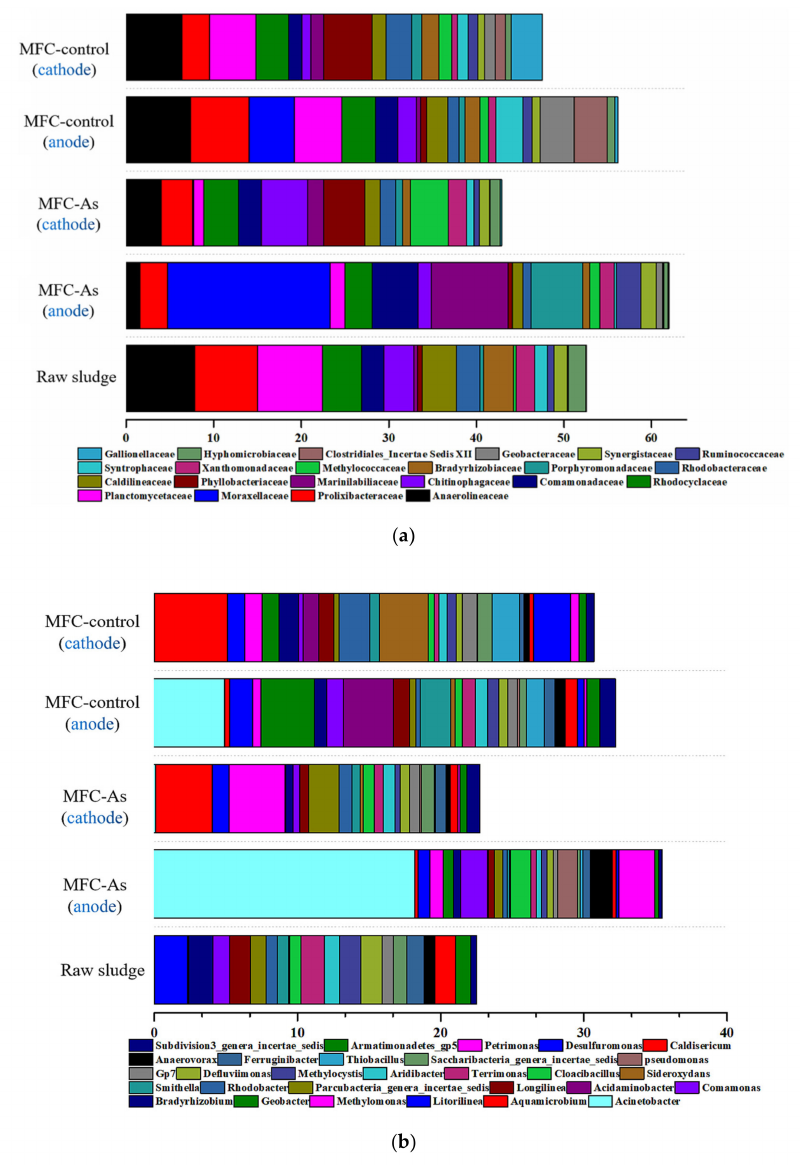
Figure 6. Microbial community composition distribution of the samples at the family ( a ) and general ( b )